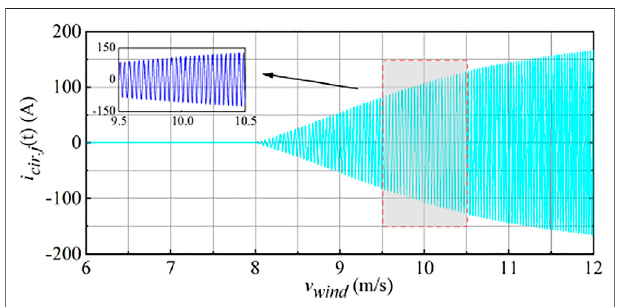
FIGURE 16 | Capacitor voltage under the proposed